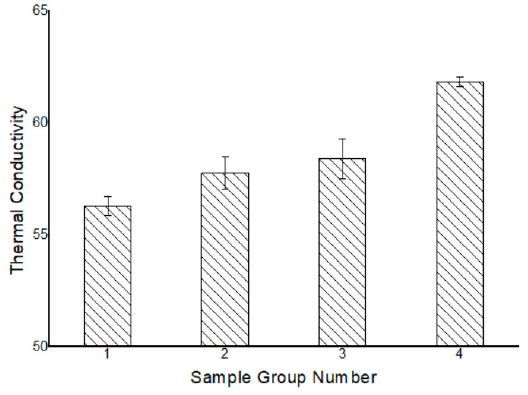
Figure 2. Thermal conductivity of WC–Co cemented carbide.